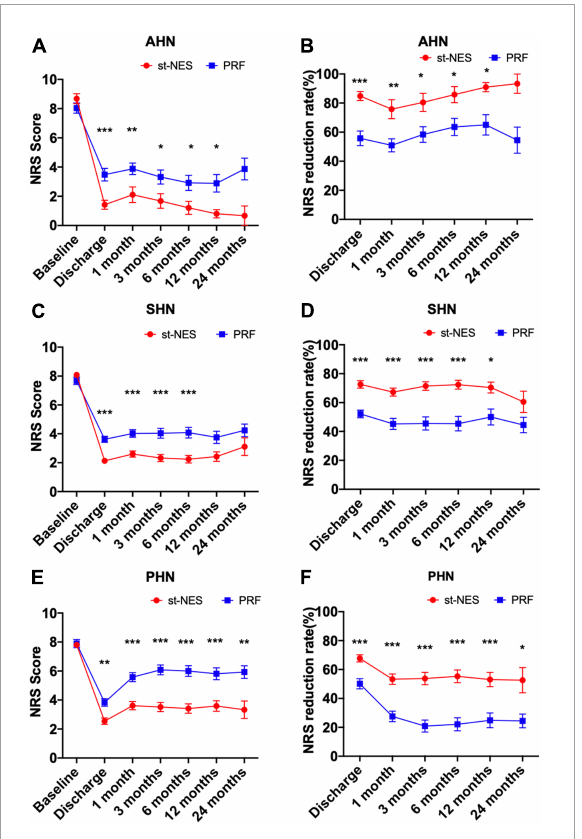
FIGURE4 (A–F) Comparison of two treatment modalities for changes of numerical rating scale (NRS) score and NRS reduction rate at each time point during follow-up in acute herpetic neuralgia (AHN), subacute herpetic neuralgia (SHN), and postherpetic neuralgia (PHN), respectively [ n = 226, * P < 0.05, ** P < 0.01, *** P < 0.001, indicate pulsed radiofrequency (PRF) group